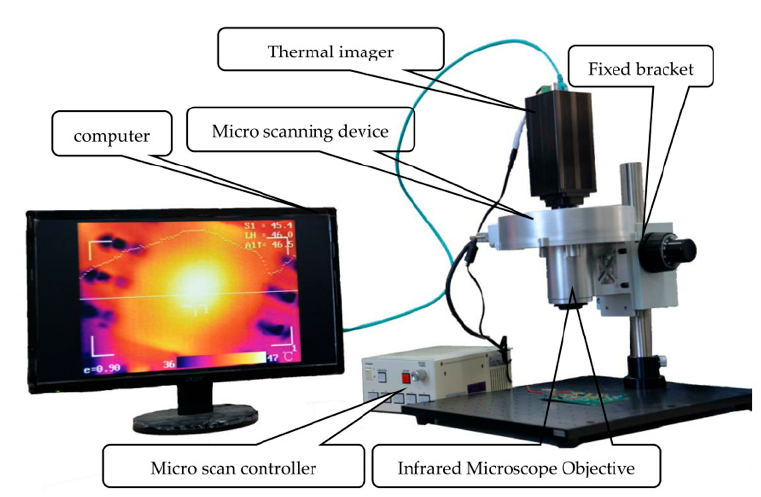
Figure 11. High-resolution thermal microscope imaging system.